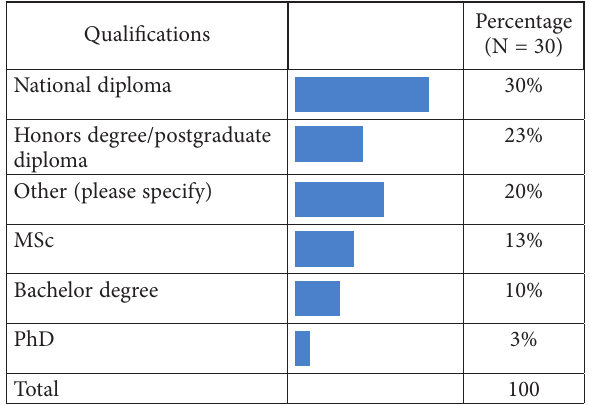
Table 2. Highest educational qualification